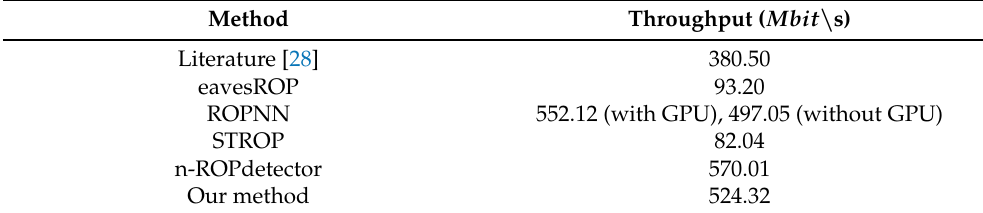
Table 4. Efficiency comparison with baselines.